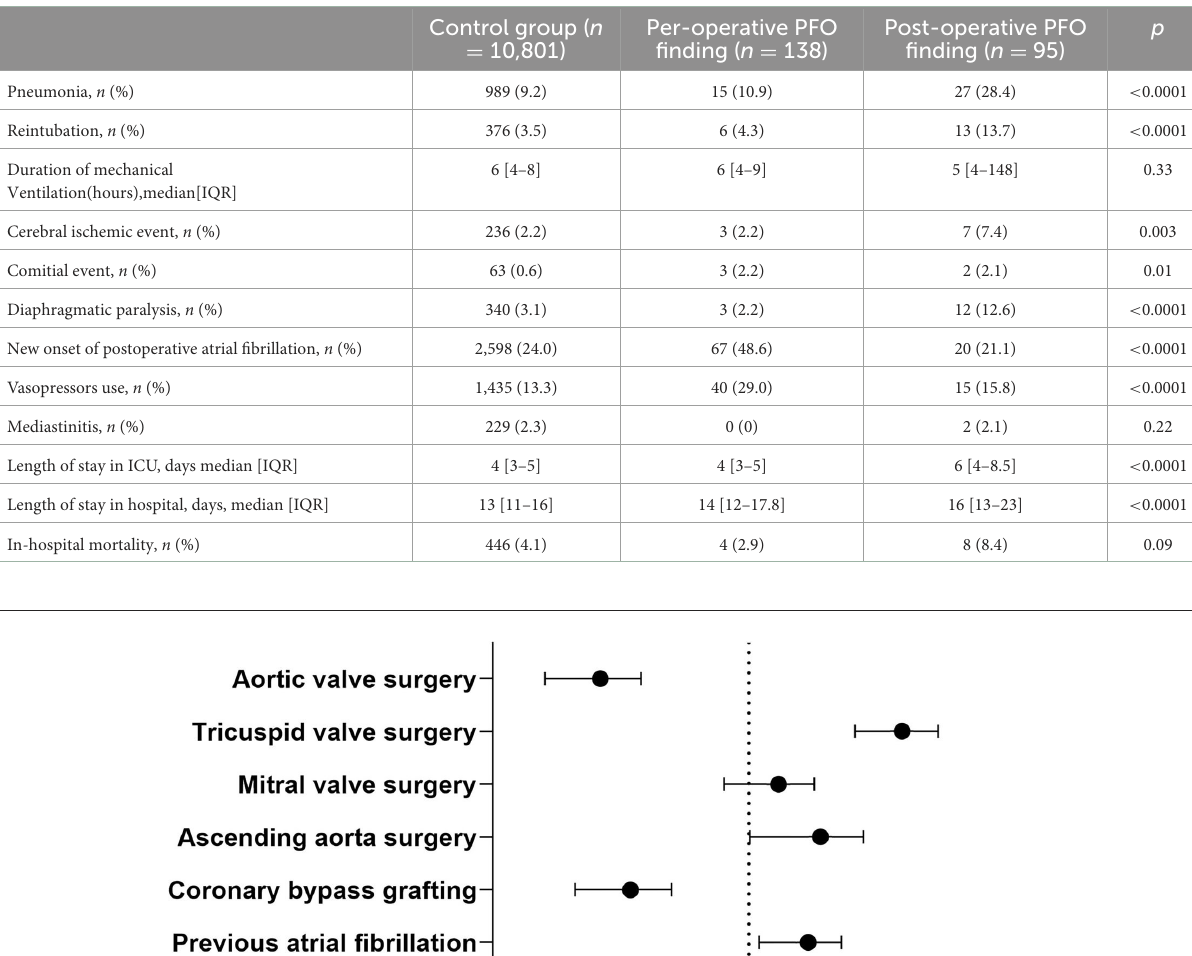
Control group ( n = 10,801)